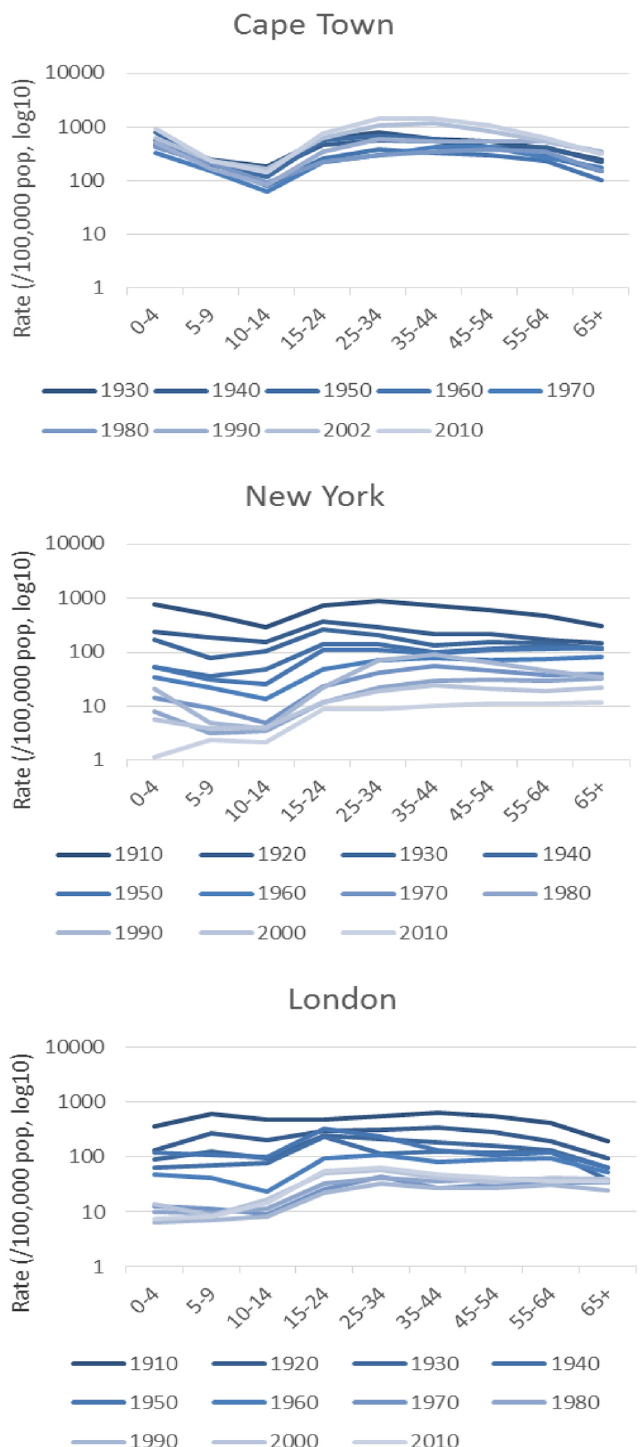
Fig 3. Age-stratified TB notification rates per decade over time. Note. Y-axes are on a logarithmic scale (base 10). Age-stratified rates in Cape Town were not available prior to 1930. Cape Town rates for 2002 and 2010 include TB in HIV-infected